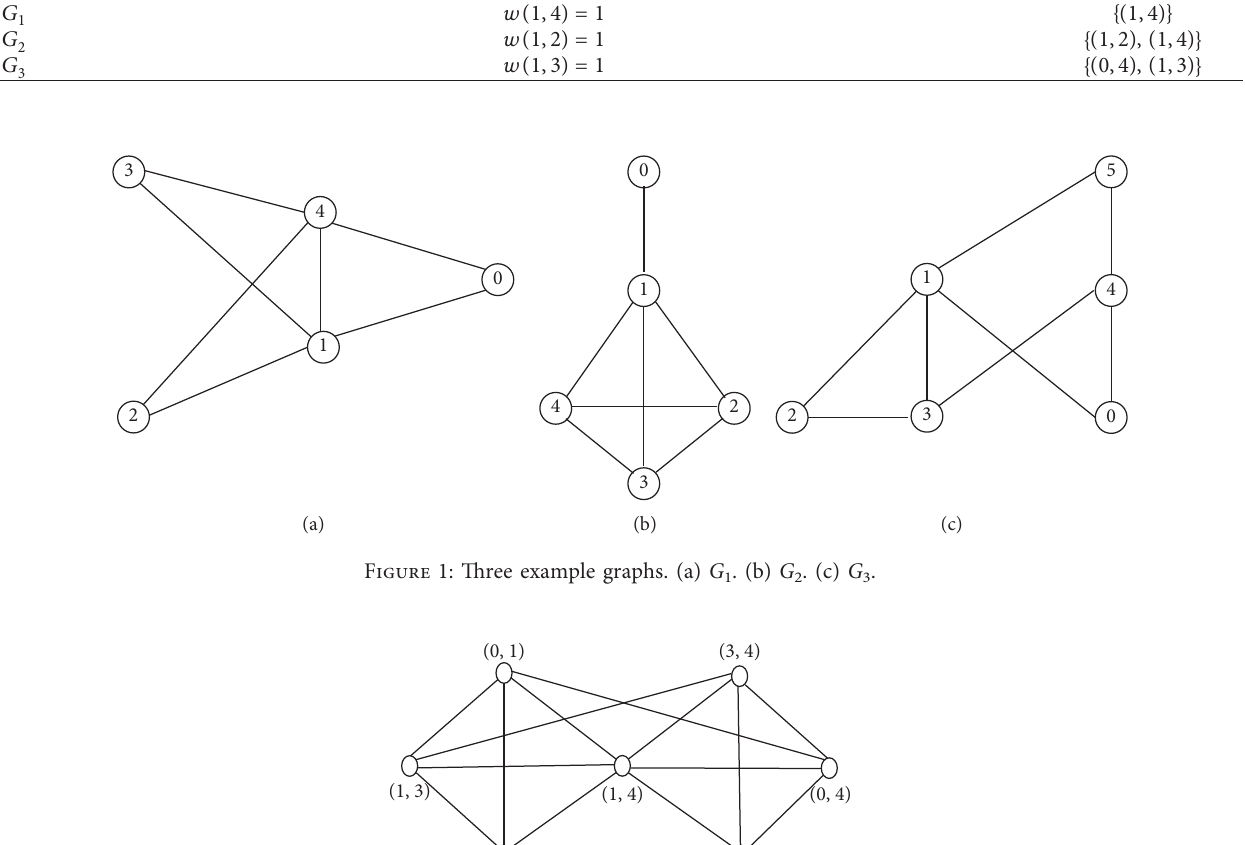
Figure 2: The line graph L ( G